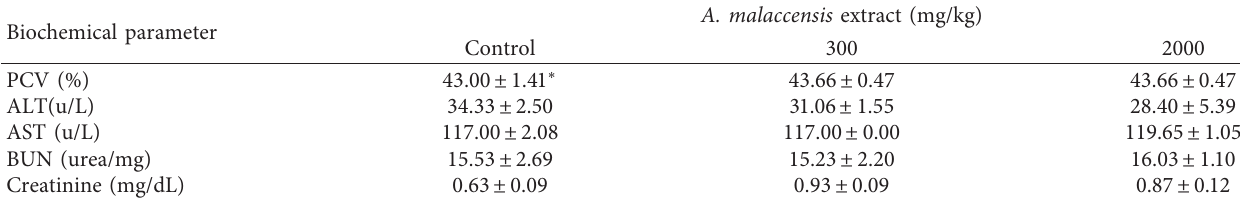
Table 2: Serum biochemical parameters of female rats.